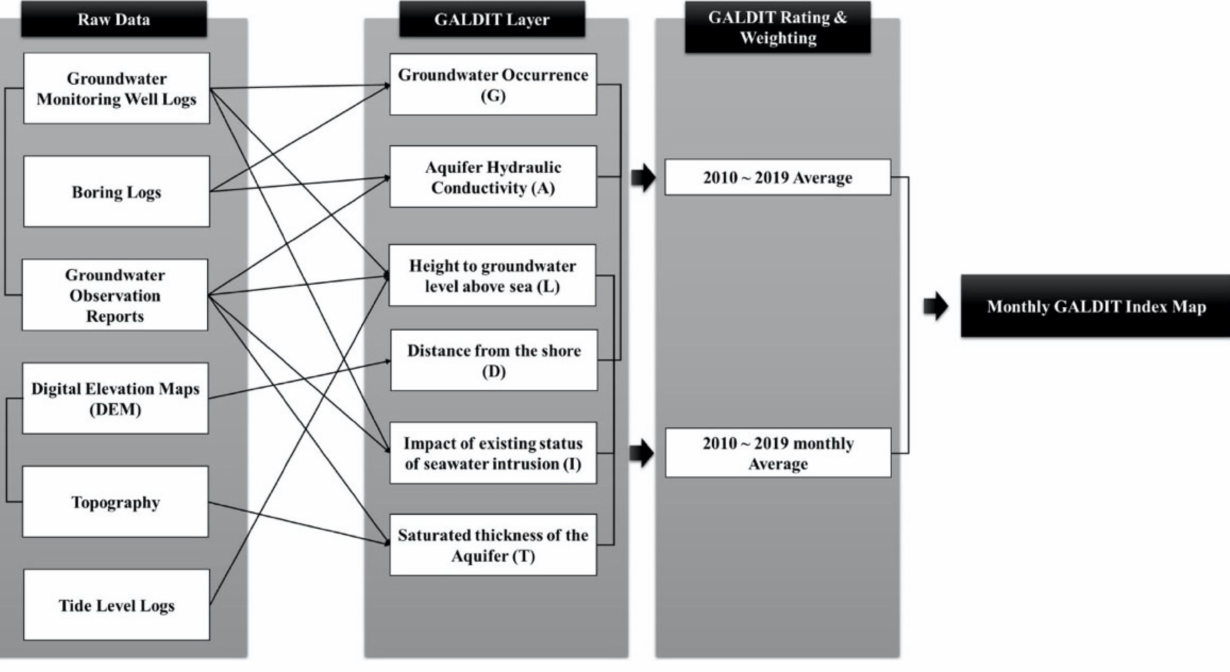
Figure 2. Procedure of monthly-based GALDIT index